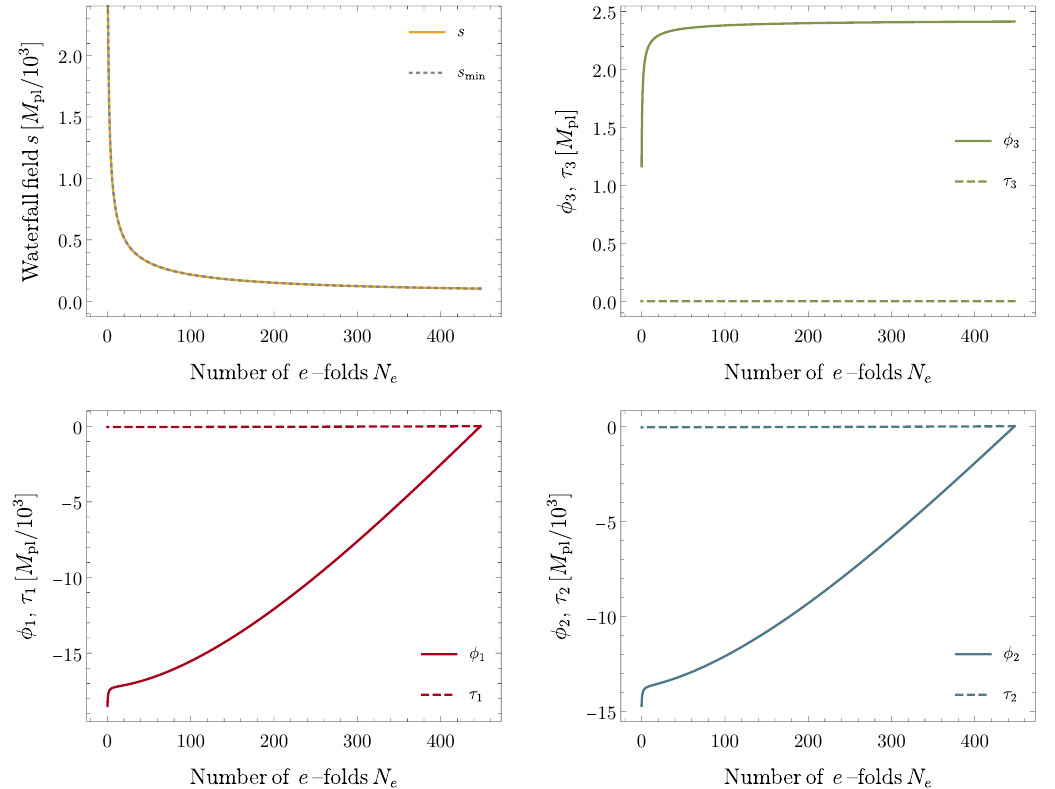
Figure 4 . The time evolution of s , φ i , and τ i ( i = 1 – 3) as function of e -folds before the end of inflation. The parameters are given in eq. (4.35) and ˆΛ = 10 10 GeV . (Top-left) The waterfall field value s (solid) given by the numerical solution and that of the analytical approximation s min (dotted) are shown. (Top-right) The inflaton φ 3 (solid) and τ 3 (dashed) are given. (Bottom) φ i (solid) and τ i (dashed) for i = 1 , 2 are shown.